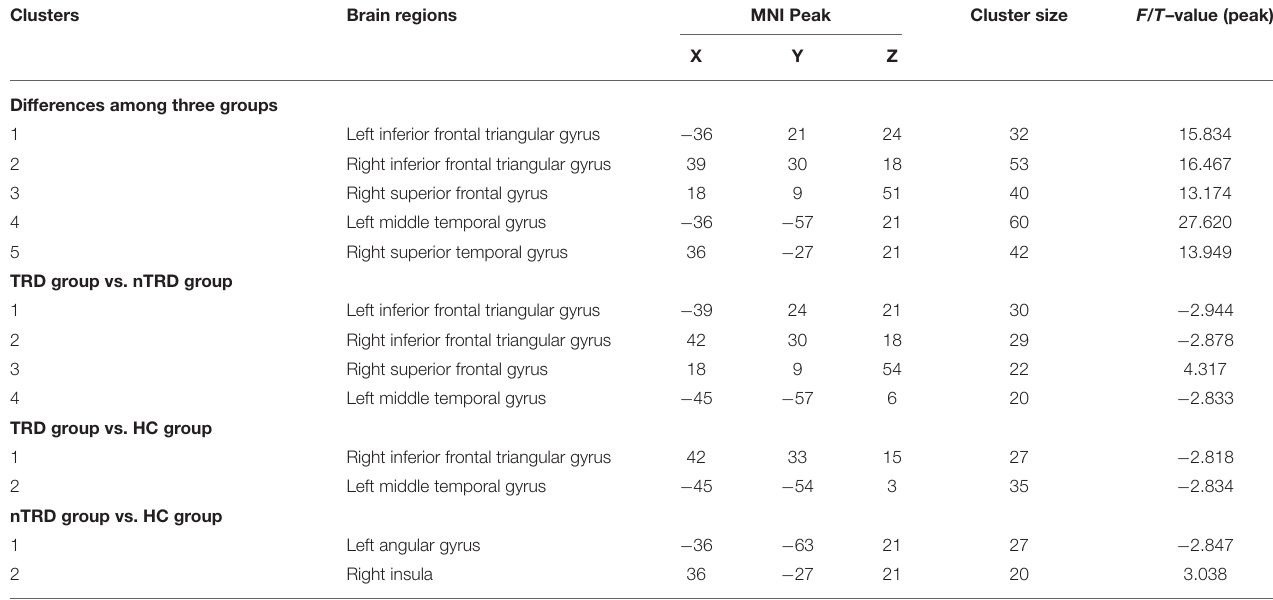
TABLE 3 | ReHo differences in TRD group; nTRD group; and HC group.